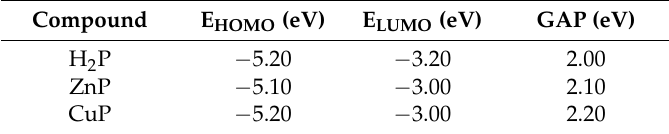
Table 2. Electrochemical data of H 2 P, ZnP, and CuP at 25 ◦ C in CH 2 Cl 2